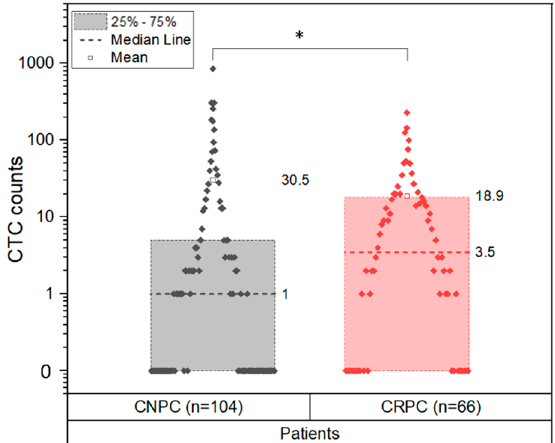
Figure 3. Presence of CTC in CNPC before initiation of therapy and CRPC. The CTC counts obtained from CNPC and CRPC patients were assessed for differences between the patient from CNPC and CRPC patients were assessed for differences between the patient cohorts. The CTC cohorts. The CTC (CTC ACCEPT corrected) counts of 104 CNPC patients (mean rank = 78.28, (CTC ACCEPT corrected) counts of 104 CNPC patients (mean rank = 78.28, median = 1) showed median = 1) showed significant difference ( p = 0.013) compared to the 66 CRPC patients (mean significant difference ( p = 0.013) compared to the 66 CRPC patients (mean rank = 96.88, median = 3.5). rank = 96.88, median = 3.5). The chi ‐ square test showed that having CTCs (CNPC n=56, CRPC n = The chi-square test showed that having CTCs (CNPC n = 56, CRPC n = 48) or not (CNPC n = 48) or not (CNPC n = 48, CRPC n = 18) was different between CNPC and CRPC patients ( p = 0.014). * Significance p < 0.05.